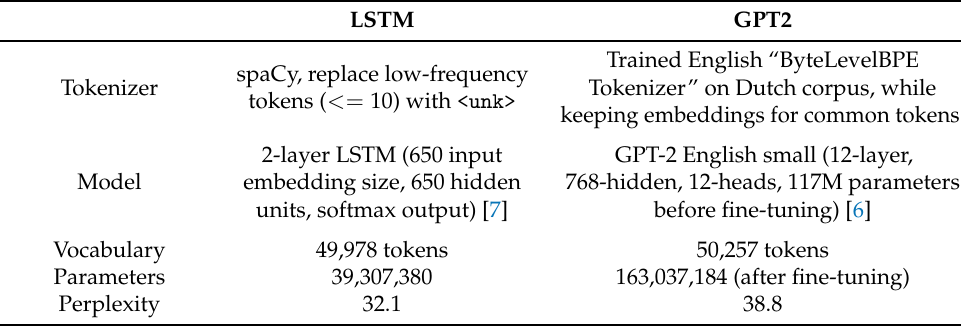
Table 2. Summary of language models used to generate synthetic text. Note that the test perplexity cannot be directly compared due to the difference in vocabulary.